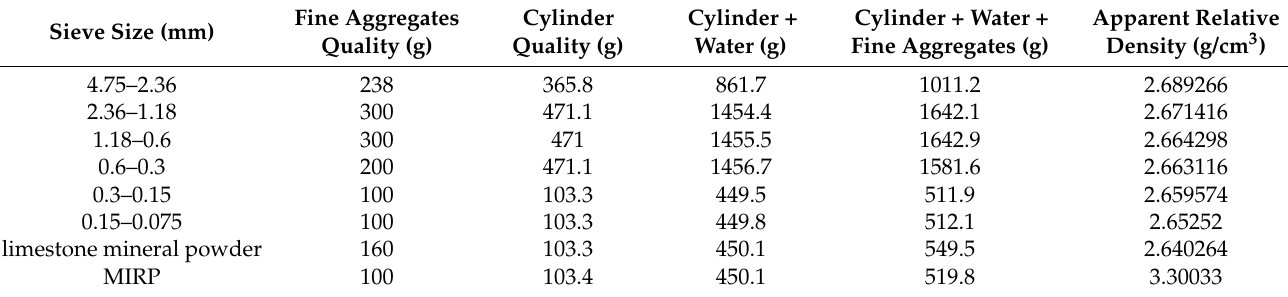
Table 2. The apparent relative density of fine